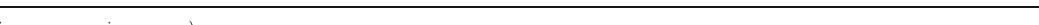
(See figure on previous page.) Fig. 4 Partial least squares discriminant analysis (PLS-DA) of the hair metabolome between the eight MCDA twin comparisons, including a